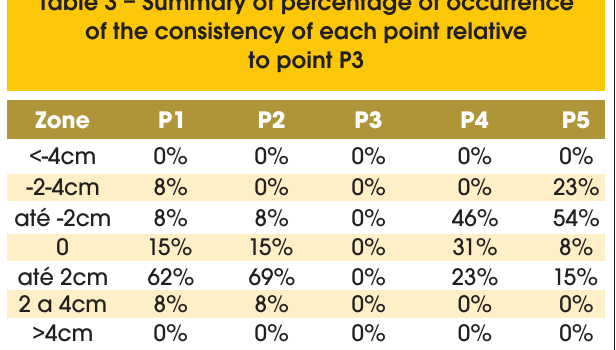
Table 3 – Summary of percentage of occurrence Table 4 – Summary of percentage of occurrence